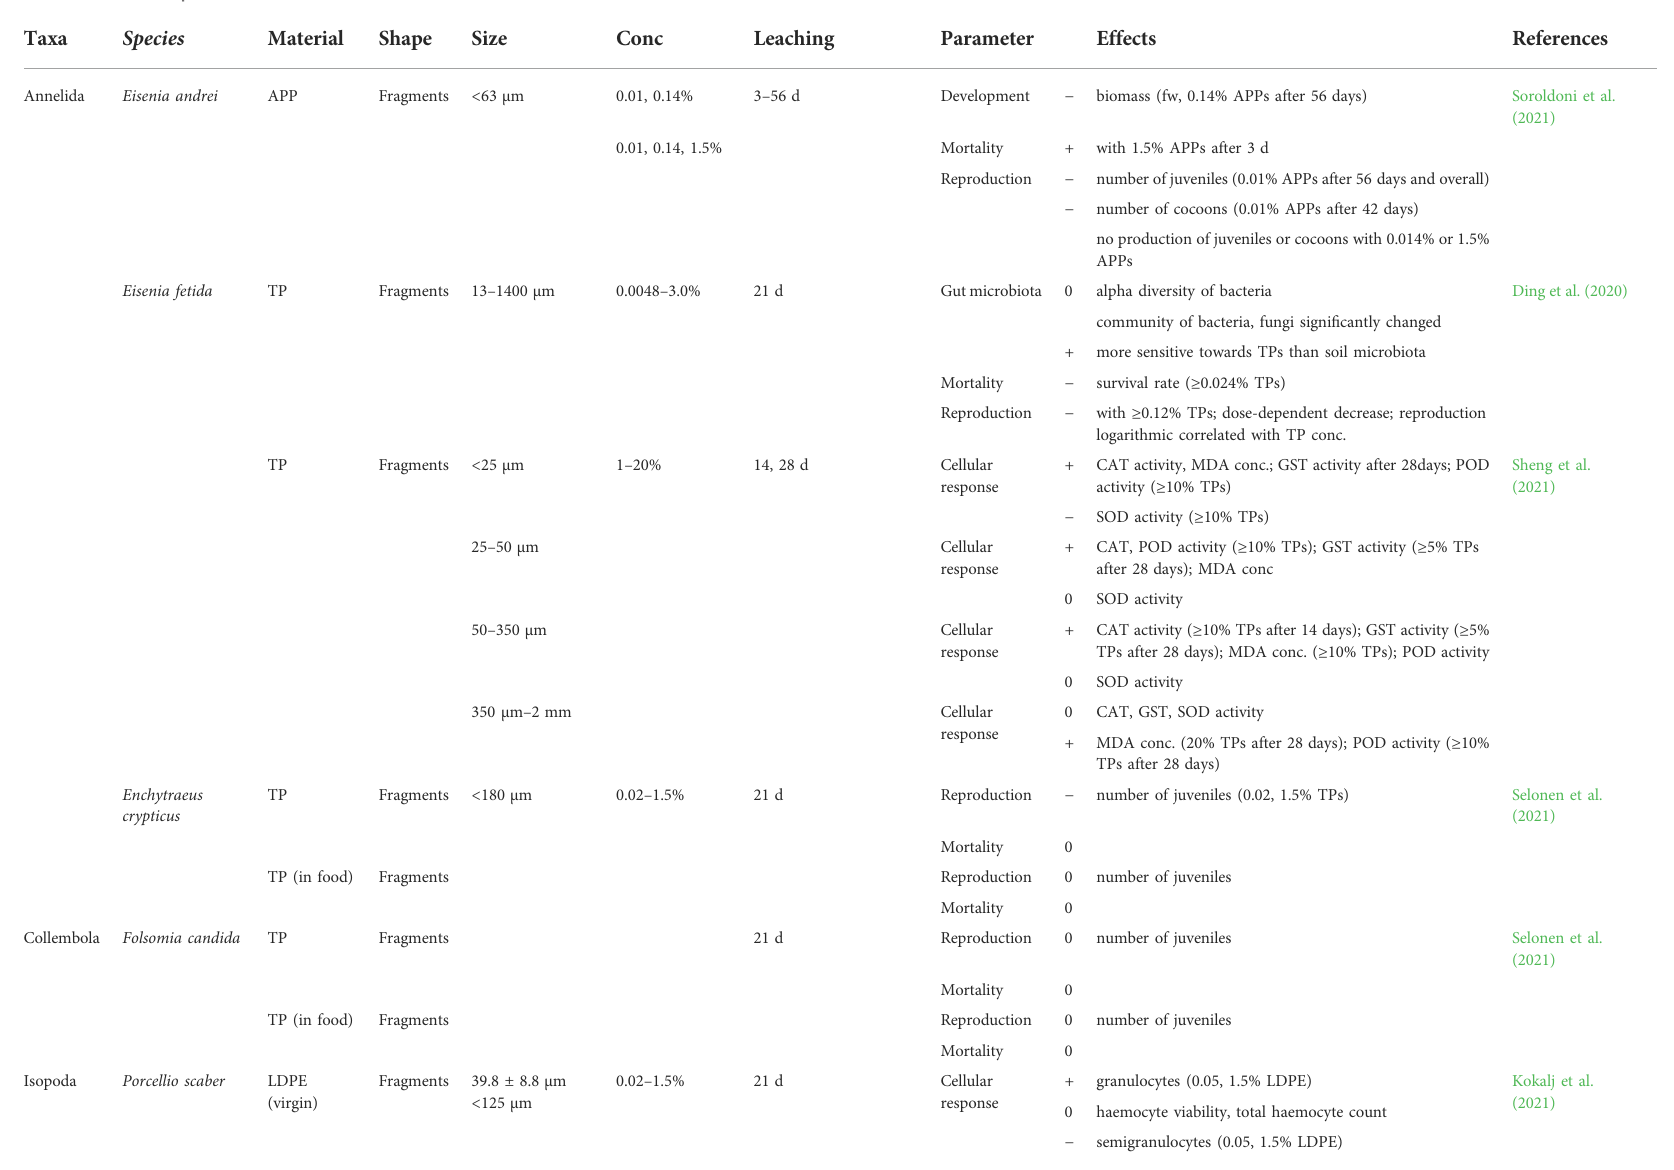
TABLE 5 Effects of plastic leachates on soil